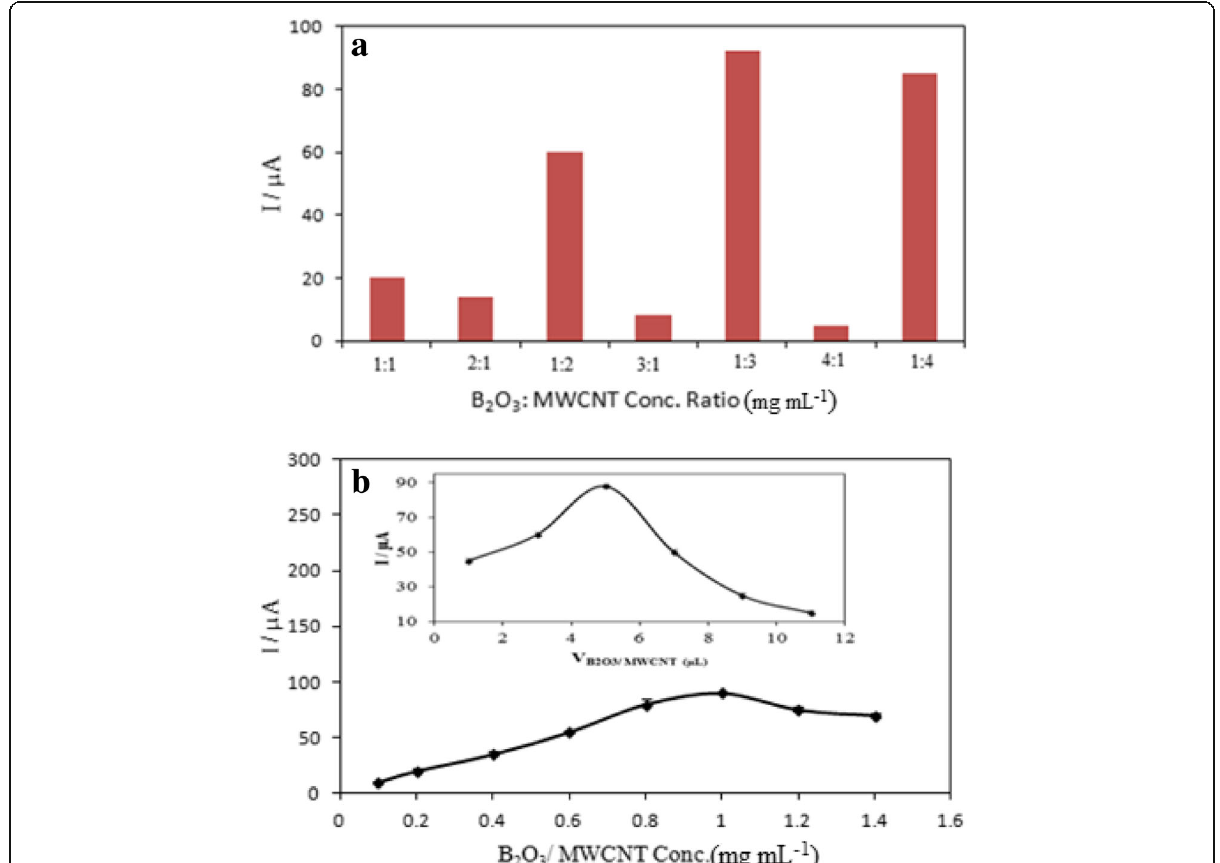
Fig. 5 Current responses of the B 2 O 3 /MWCNT/GCE sensor from a loading variable ratios of B 2 O 3 to MWCNT. b Different concentrations of B 2 O 3 / MWCNT towards 0.1 mM paracetamol oxidation in 0.1 M PBS (pH 4.0). Inset is the current responses of B 2 O 3 /MWCNT composite volumes injected on the GCE; error bar = ± S.D. and n = 3